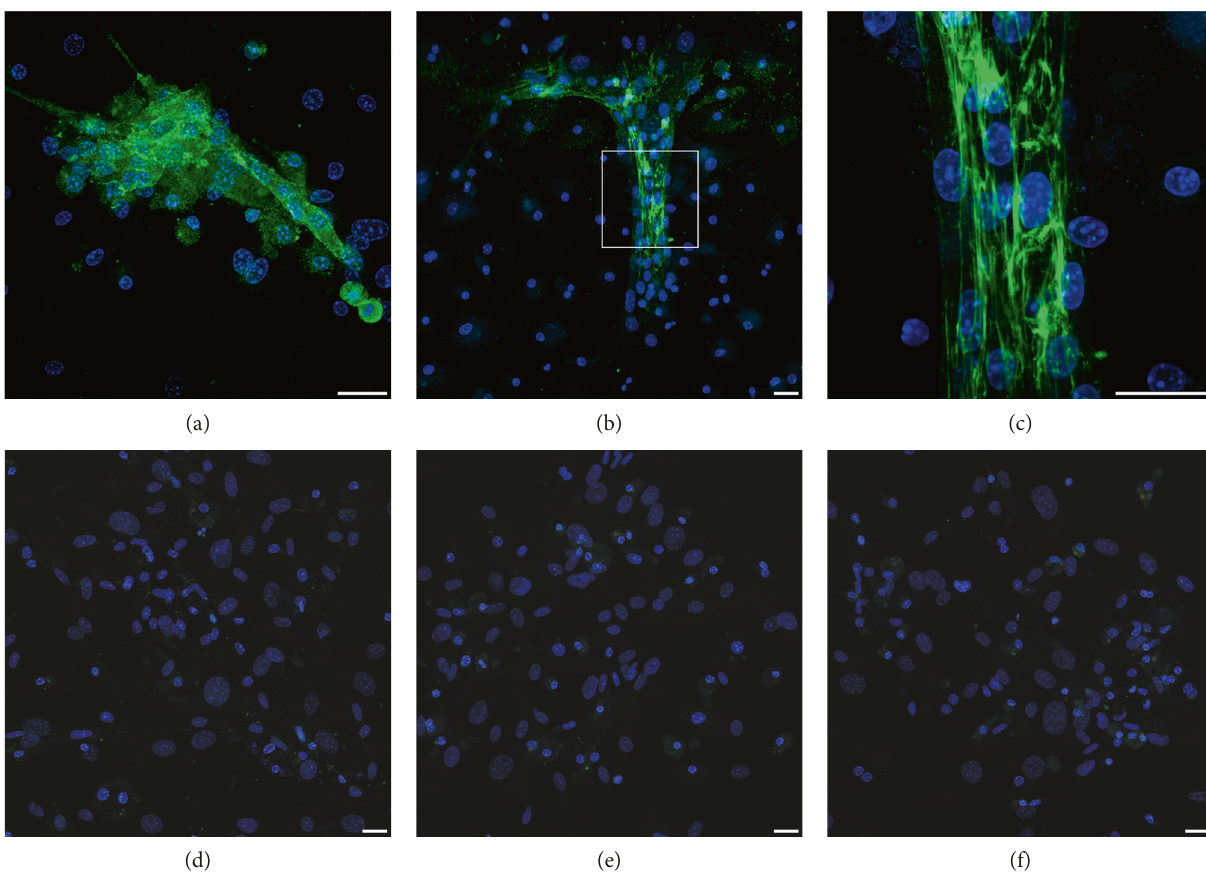
Figure 4: Expression of sarcomeric α -actinin by MSCs cultured under various conditions. MSCs were immunostained for α -actinin (green) and DAPI counterstained (blue), after incubation in the presence or absence of BIX01294 and/or TSA for 2 days and Wnt treatments for 7 days. MSCs treated with Wnt11 following exposure to (a) BIX01294 or (b), (c) BIX01294+TSA exhibited clusters of α -actinin-positive cells. (c) A higher magni fi cation view of the boxed area in the previous panel indicates that the high intensity α -actinin staining was not yet exhibited in a striated pattern. In contrast, α -actinin staining was not observed either if the cultures were (d) not pretreated with BIX01294 ± TSA or if pretreatment with BIX01294 and TSA was followed by either (e) the absence of Wnt11 or (f) treatment with Wnt3a instead of Wnt11. Scale bar =25 μ